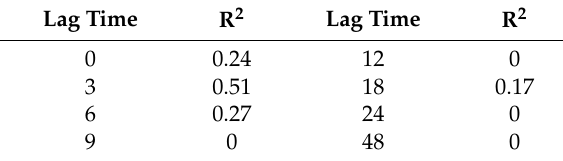
Table 6. Correlation coefficients between LAI and RDI after applying a lag